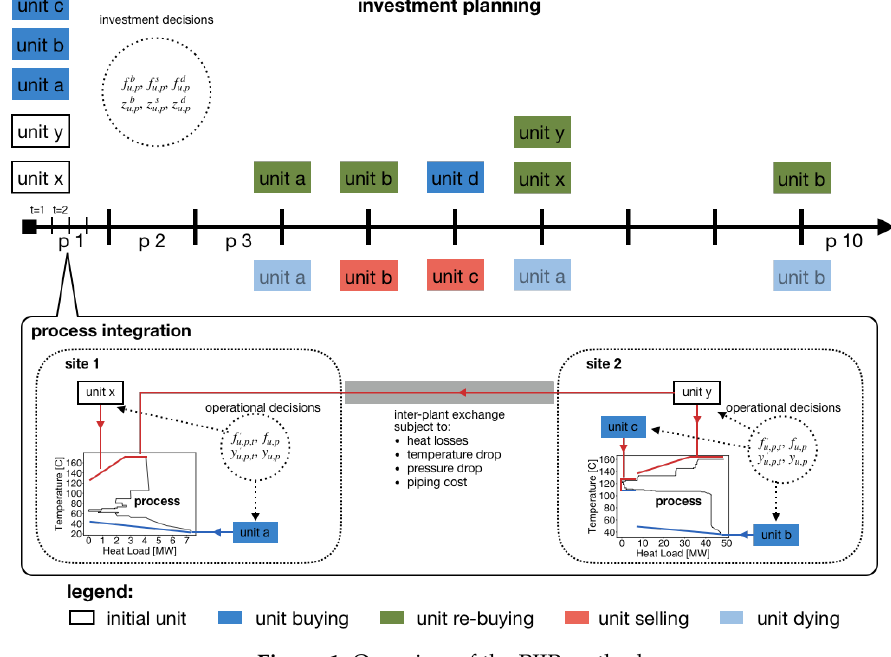
Figure 1. Overview of the PIIP